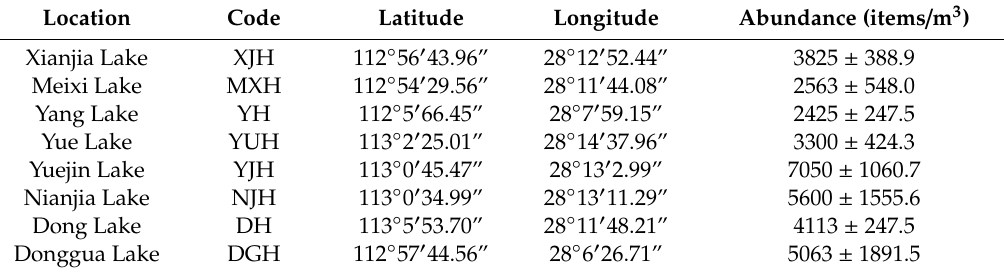
Table 1. Information about the sampling sites in this